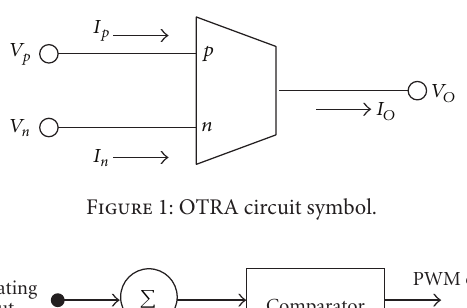
Carrier waveform generator F 2: e scheme of PWM